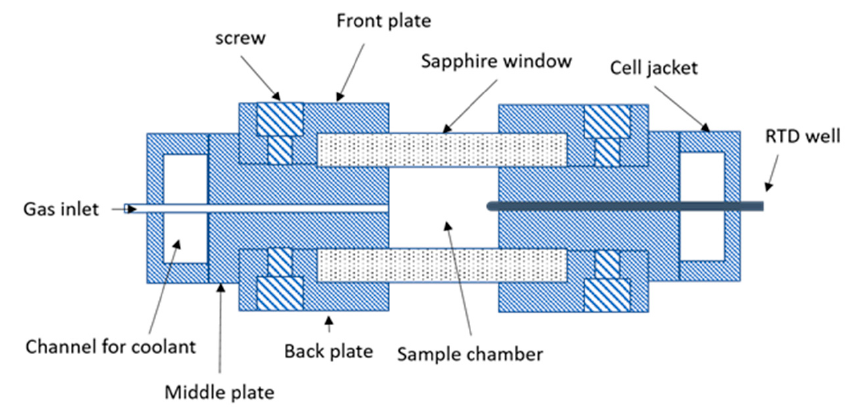
Figure 10. High-pressure optical cell (HPOC) for spectroscopy studies.